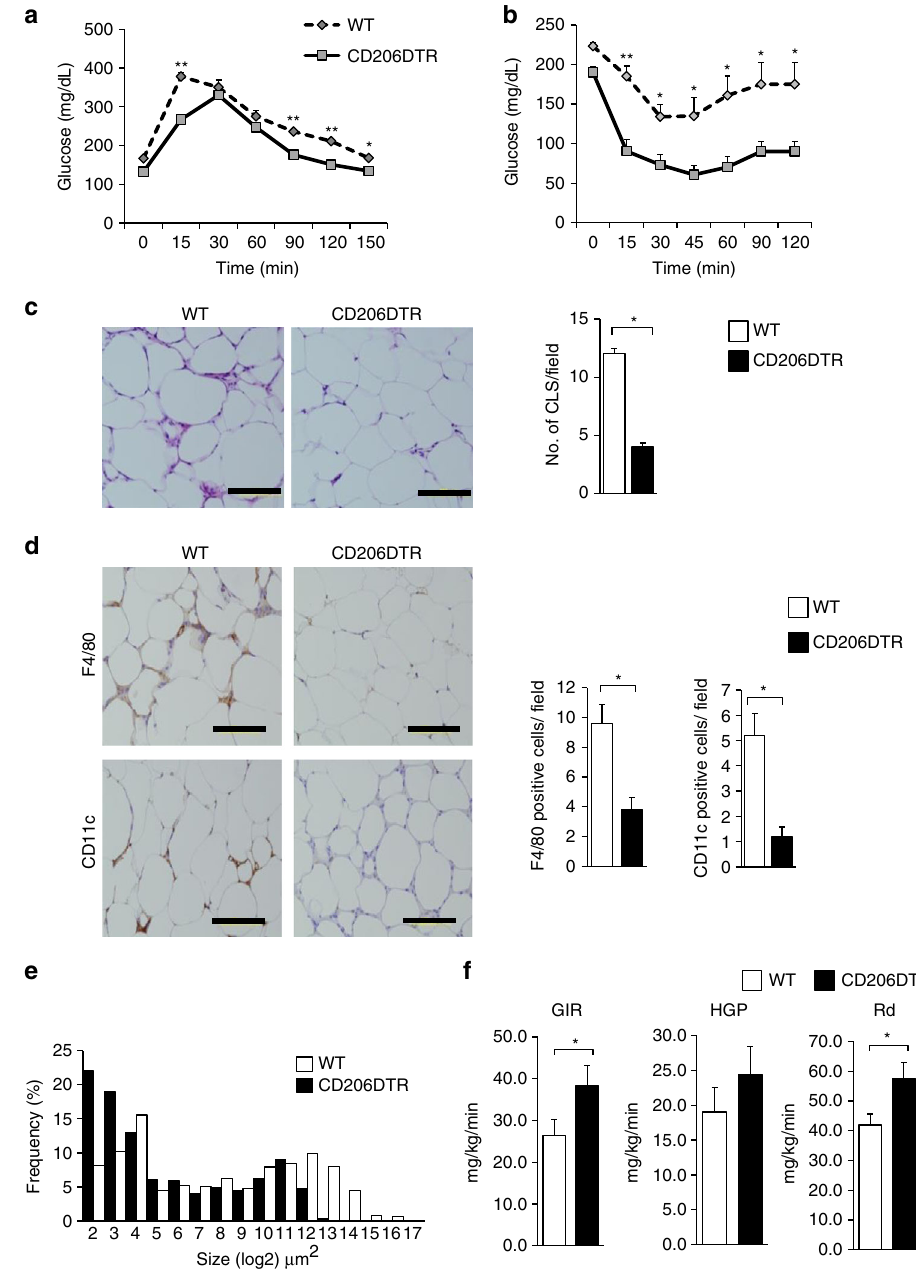
Fig. 8 CD206 + M2-like ATMs depletion promote insulin sensitivity in obese mice. a IP-GTT and b IP-ITT in 16-week HFD-fed mice after DT treatment ( n = 5 mice per group). c HE staining of eWAT ( left panel ). The number of CLS/ fi eld is given in right panel. ( Scale bar , 200 μ m). d Representative images of a paraf fi n section of eWAT of the DT-treated HFD-fed CD206DTR and WT mice stained with anti-CD11c and anti-F4/80 antibody ( left panel ). The number of F4/80 and CD11c positive cells/ fi eld ( right panel ) ( n = 3 – 4 mice per group) ( Scale bar , 200 μ m). e A histogram of adipocyte cell size in the eWAT of DT-treated HFD-fed CD206DTR mice compared with WT mice ( n = 4 – 5 mice per group). f Hyperinsulinemic-euglycemic clamp study showed glucose infusion rates (GIR), hepatic glucose production (HGP), and rate of glucose disappearance (Rd) in HFD-fed DT-treated CD206DTR and WT mice ( n = 9 – 10 mice per group). The data are shown as the means ± SEM. * P < 0.05, ** P < 0.01 compared with littermates by Student ’ s t